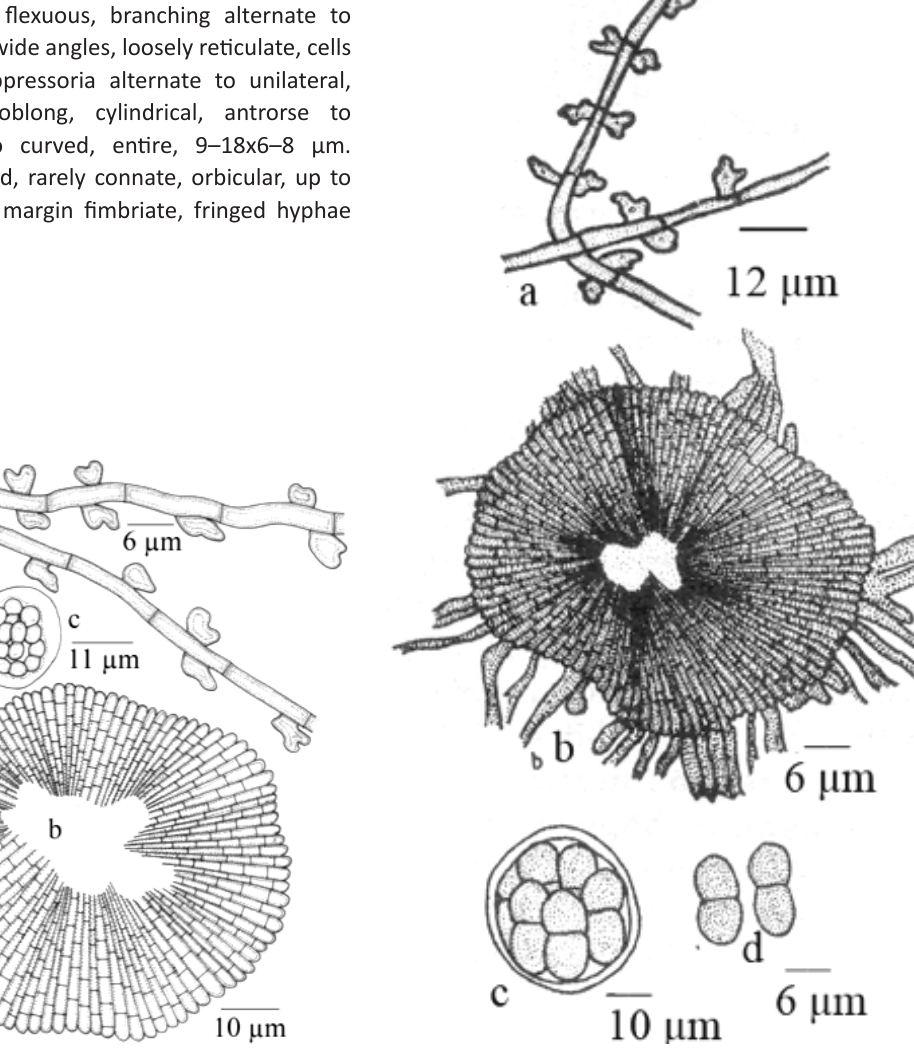
Figure 135. Asterina clausenicola a - Appressorium; b - Thyriothecium; c - Ascus; d -